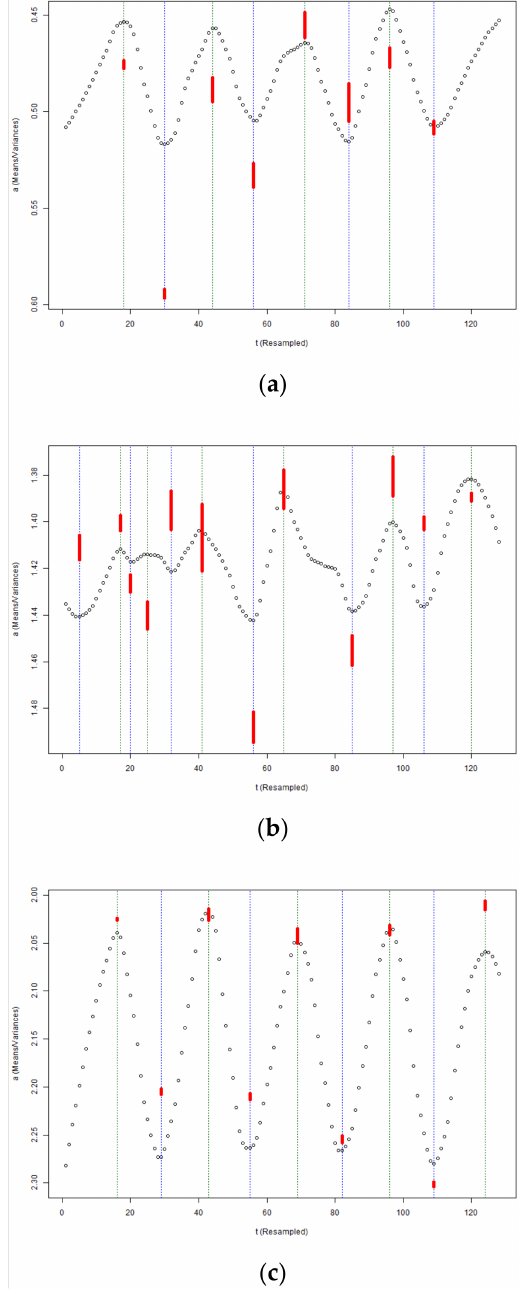
Figure 9. Means and peak/valley variances of resampled data for the 2.5-blade turbine. ( a ) Based on datasets recorded along the X axis with no wind imposed. ( b ) Based on datasets recorded along the Y axis with no wind imposed. ( c ) Based on datasets recorded along the Z axis with no wind